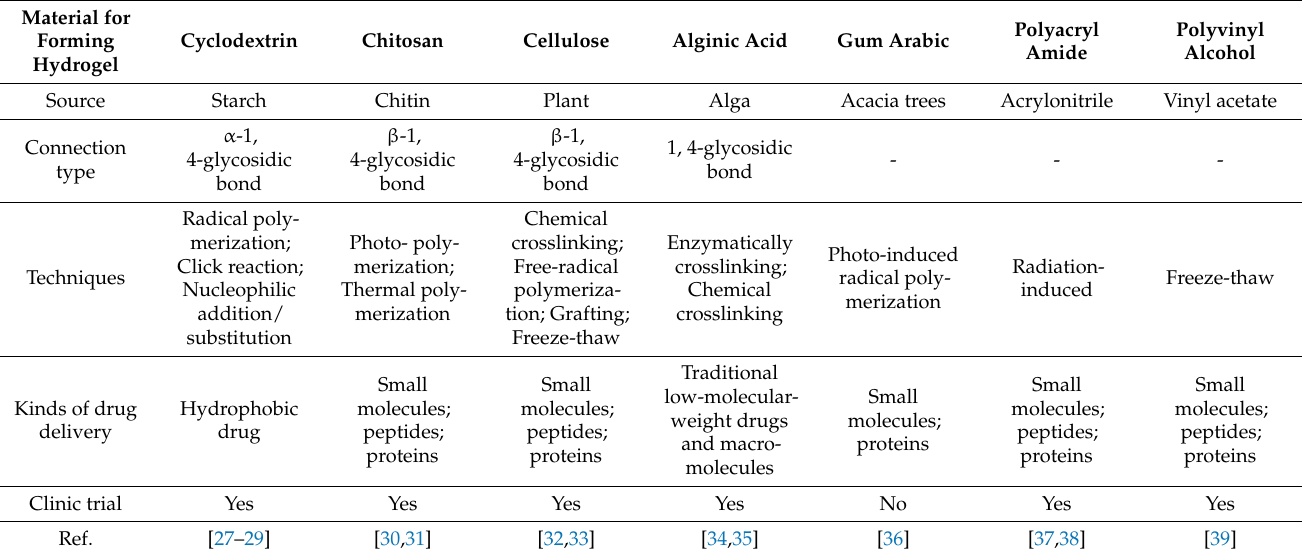
Table 1. Comparison of cyclodextrin-containing hydrogels with other types of